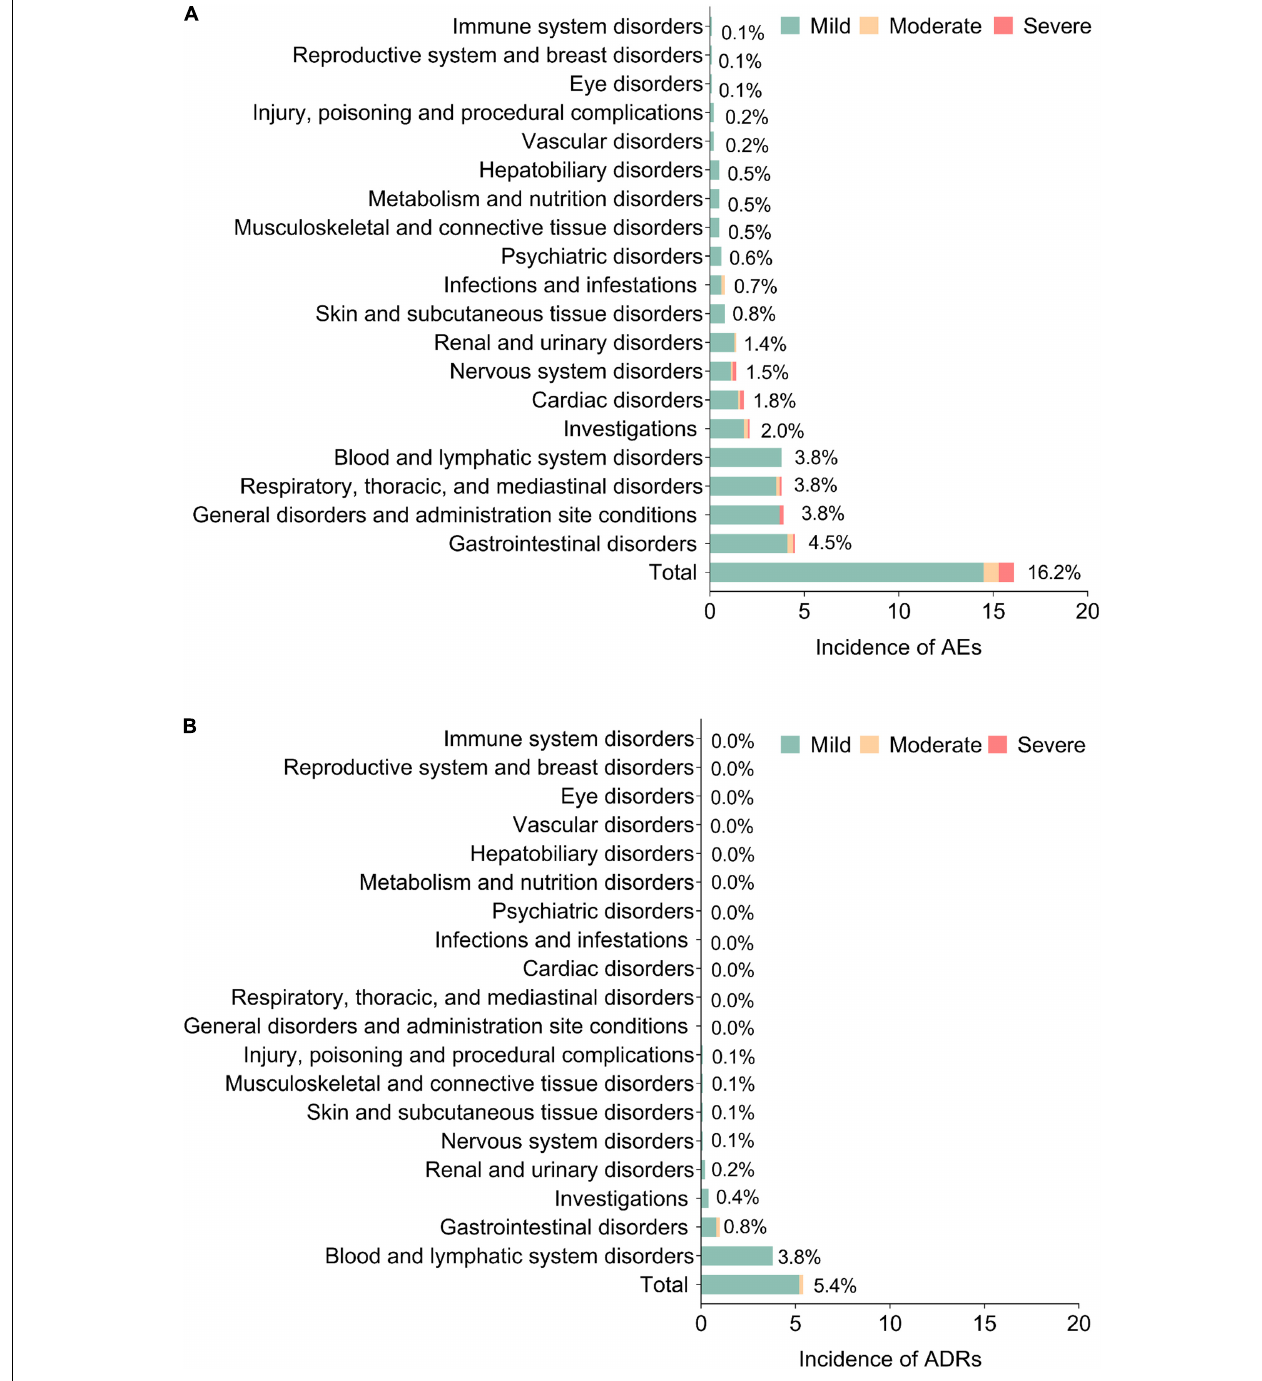
45 (3.7%) patients and bleeding was reported in 19 (1.5%) patients ( Figure 1